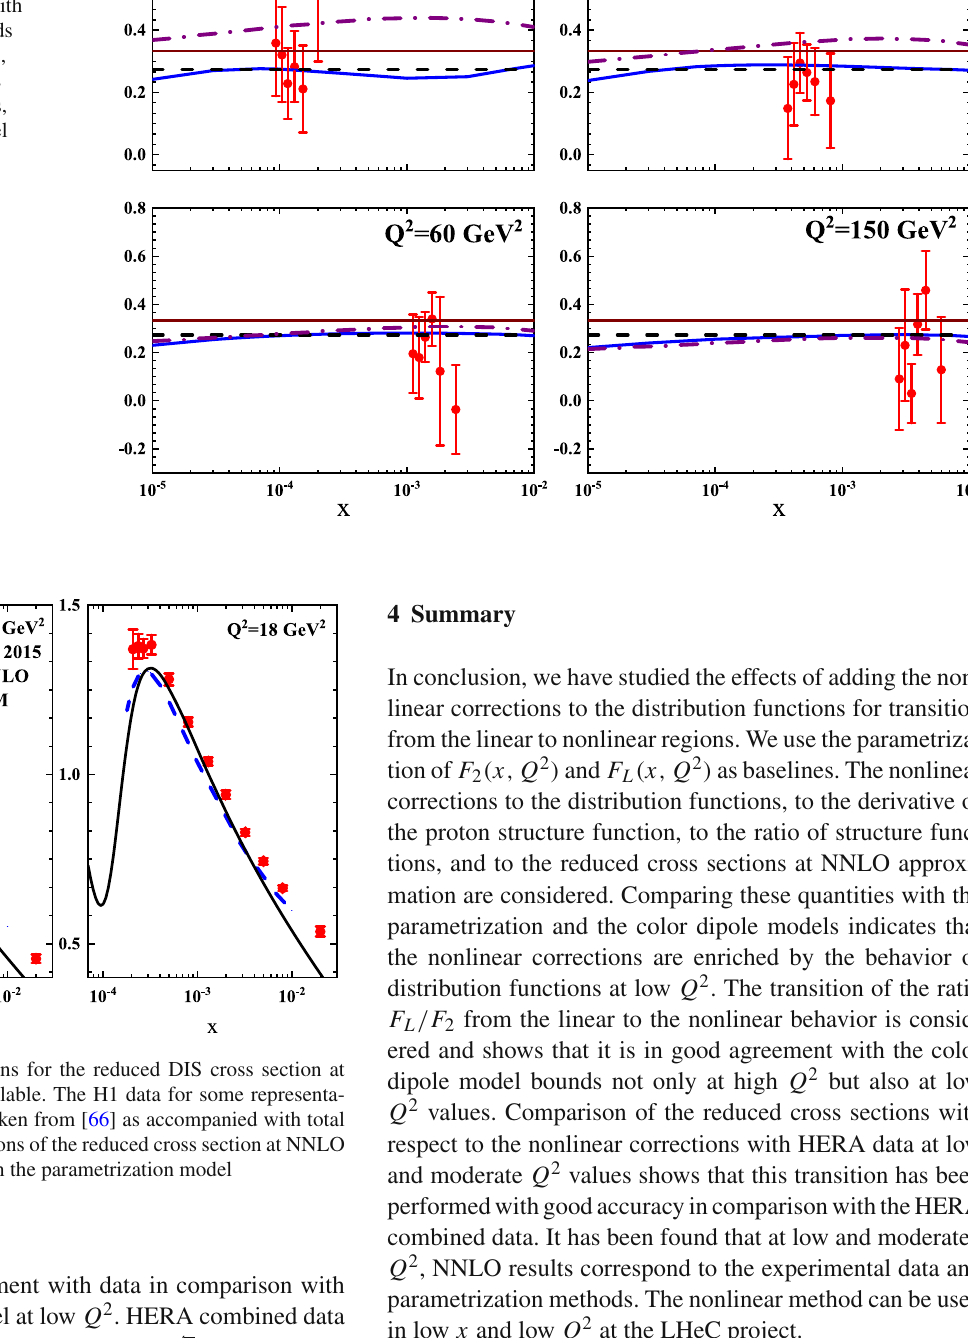
improve the good agreement with data in comparison with the parametrization model at low Q 2 . HERA combined data √ s = 318 GeV as [66] are taken with center of mass energy accompanied with total errors. These low- x predictions are fully compatible with the H1 data presented in [66]. The non- linear corrections are depicted and compared with the linear parametrization models in this figure. Consequently, the non- linear corrections make it possible to perform the high-order corrections to the ultra-high-energy